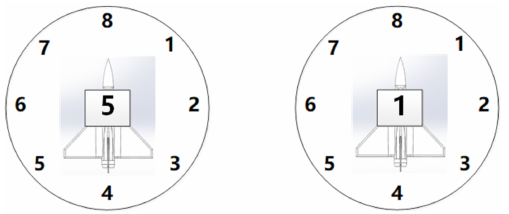
Figure 10. Eight directions of UAVs in square 5 and square